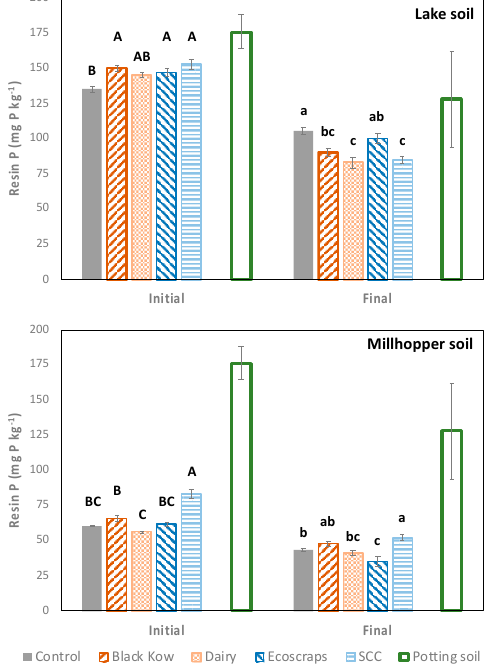
Figure 2. Mean ( ± standard errors) soil phosphorus concentrations collected at planting (initial) and harvest (final) in the Lake ( top ) and Millhopper ( bottom ) soil. Different letters represent statistically different means at each week based on Tukey’s HSD ( α ≤ 0.05). The potting soil was not included in the analysis.